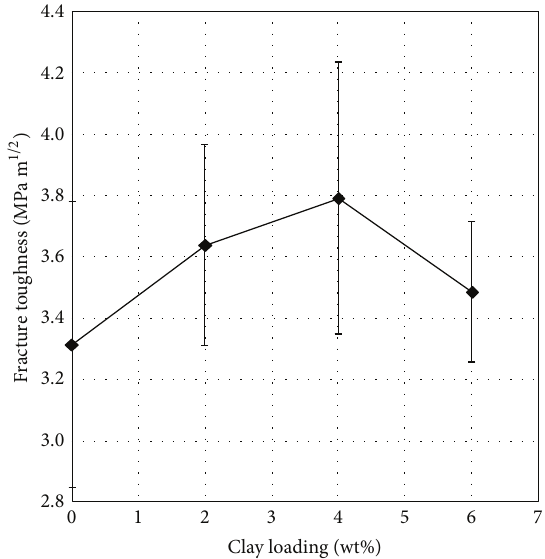
Figure 7: Effect of clay loading on the fracture toughness of UP/glass fiber/clay